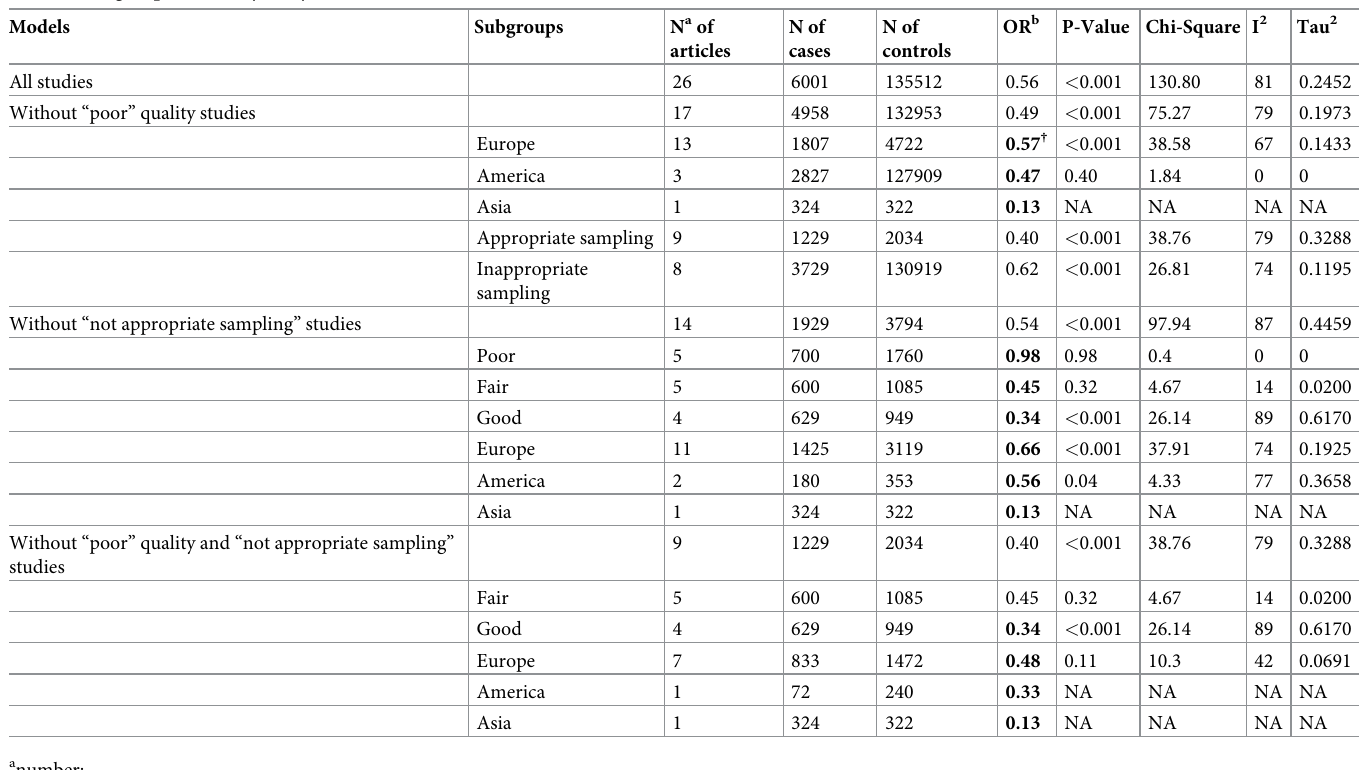
Table 3. Subgroups sensitivity